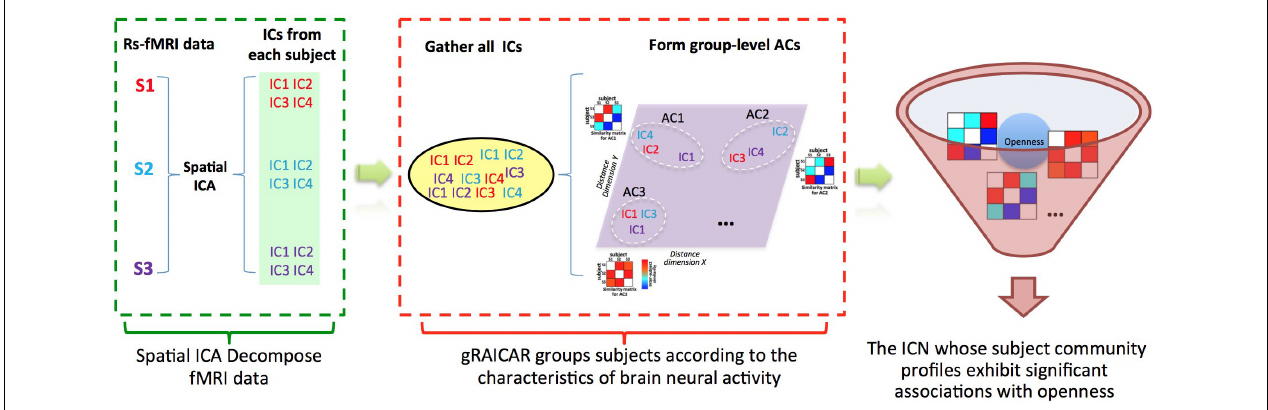
FIGURE 1 | Demonstration of data analysis workflow. For simplicity, we assume that there are only three subjects (denoted as S1, S2, and S3). First, the fMRI data of subjects are decomposed individually by using spatial independent component analysis (ICA) into spatial components (ICs). Assume that for each subject we can get four ICs that are color coded to indicate which subject they are from. The resultant ICs maps are presented in the green layer. Second, all of the ICs from individual subjects were pooled in gRAICAR (as presented in the yellow layer). We present a distance space depicting the similarity between all ICs in the purple layer. The intention of gRAICAR in this part is to identify ICs that are from different individuals but are close to each other (as marked with white dashed circles). The group-level aligned components (ACs) were formed by these clustered ICs sequentially, and a community detection algorithm can be applied to each AC to identify homogeneous subject communities among all subjects. Third, we try to seek the intrinsic connectivity networks whose subject community profiles exhibit significant associations with openness.